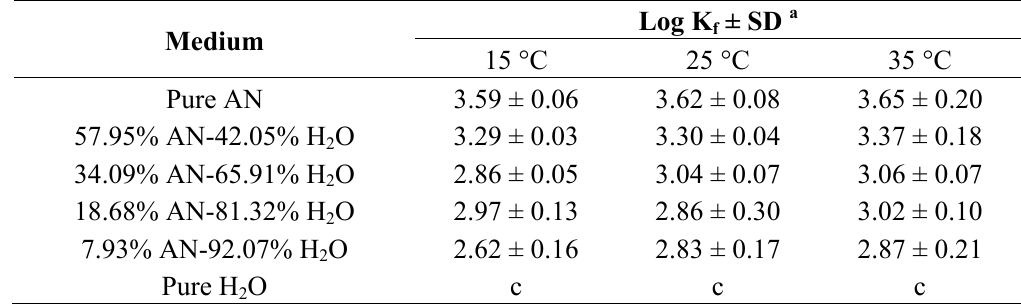
Table 1. Formation constants for different CMCR-Ti(OH)(OH binary mixtures at various